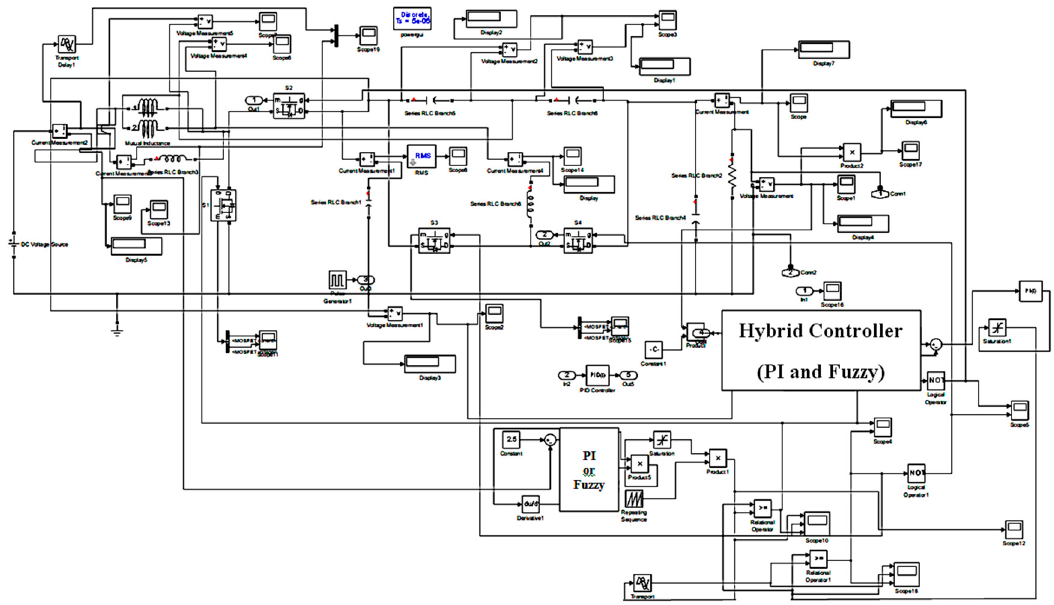
Figure 35. Simulation diagram of bidirectional DC–DC converter with proposed controller.